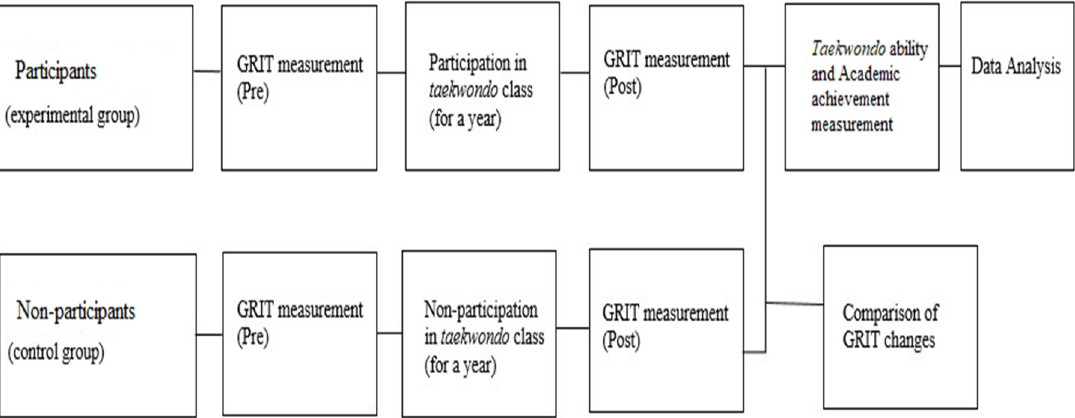
Figure 1. Research Figure 1. Research procedure.